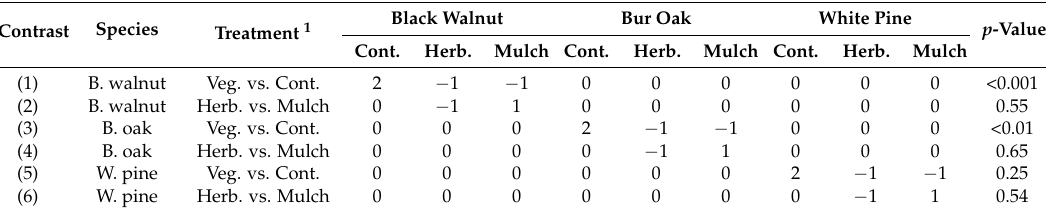
Figure 5. Species × Vegetation treatment interaction for growth variables measured at the end of the fifth growing season in an agricultural riparian buffer: ( a ) total height ( p < 0.05), ( b ) diameter at breast height (DBH) ( p < 0.05), and ( c ) stem volume per tree ( p < 0.01). Vertical bars represent standard error of the difference (SED). Table 4. A priori contrasts for the ANOVA testing the effects of Species and Vegetation treatment on stem volume after 5 years.